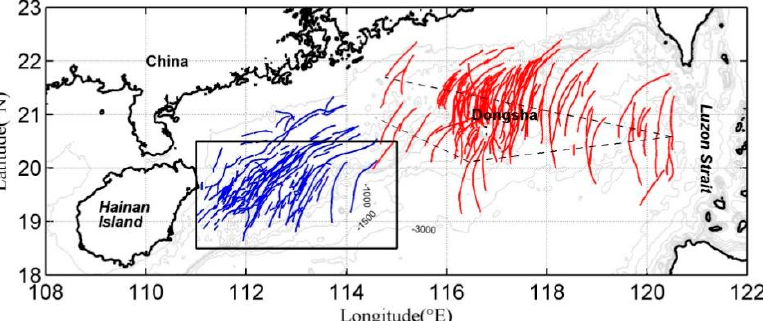
Figure 1. Satellite observations of NLIWs. The black rectangle shows the study region. The red and black lines represent the satellite-observed wavefronts of NLIWs. The red lines are those provided by Zhao et al. [13], and the blue lines are extracted from the collected satellite images in this study. The black dashed lines show the commonly recognized propagation path of NLIWs originating from the Luzon Strait.